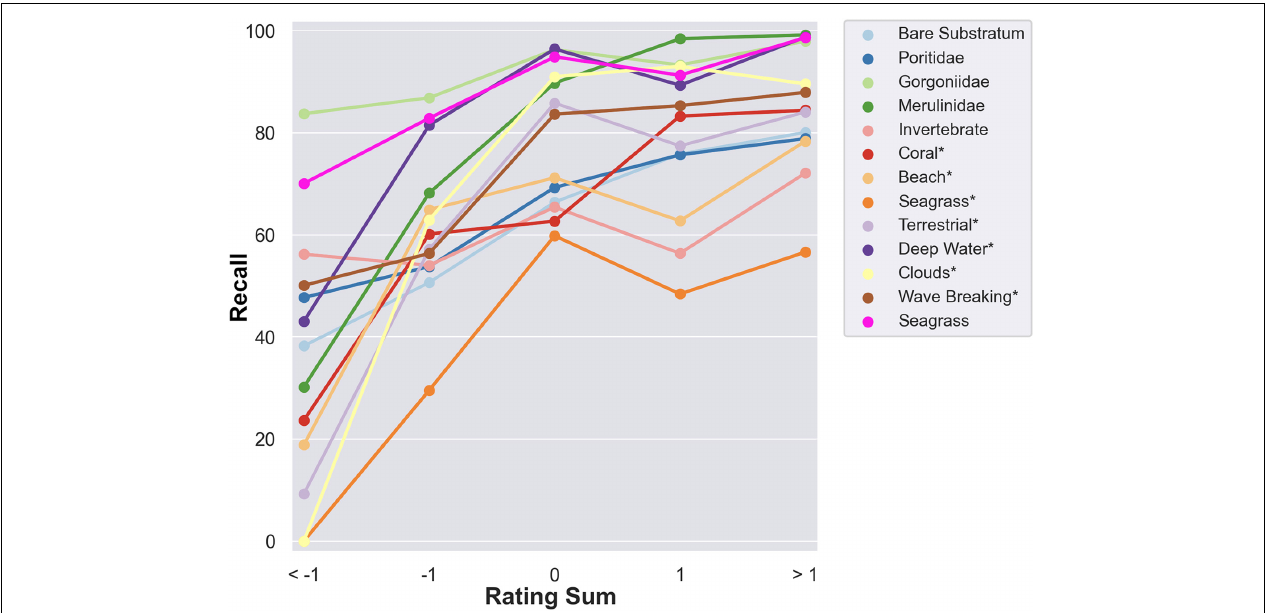
FIGURE 12 | Class label recall across user classification sets with a given rating sum. Class labels with an asterisk indicate that the class label is used purely in satellite classifications. This figure only includes class labels that have a linear regression with a slope of three or higher. These class labels show that player-generated ratings can be used as an estimation of classification quality.